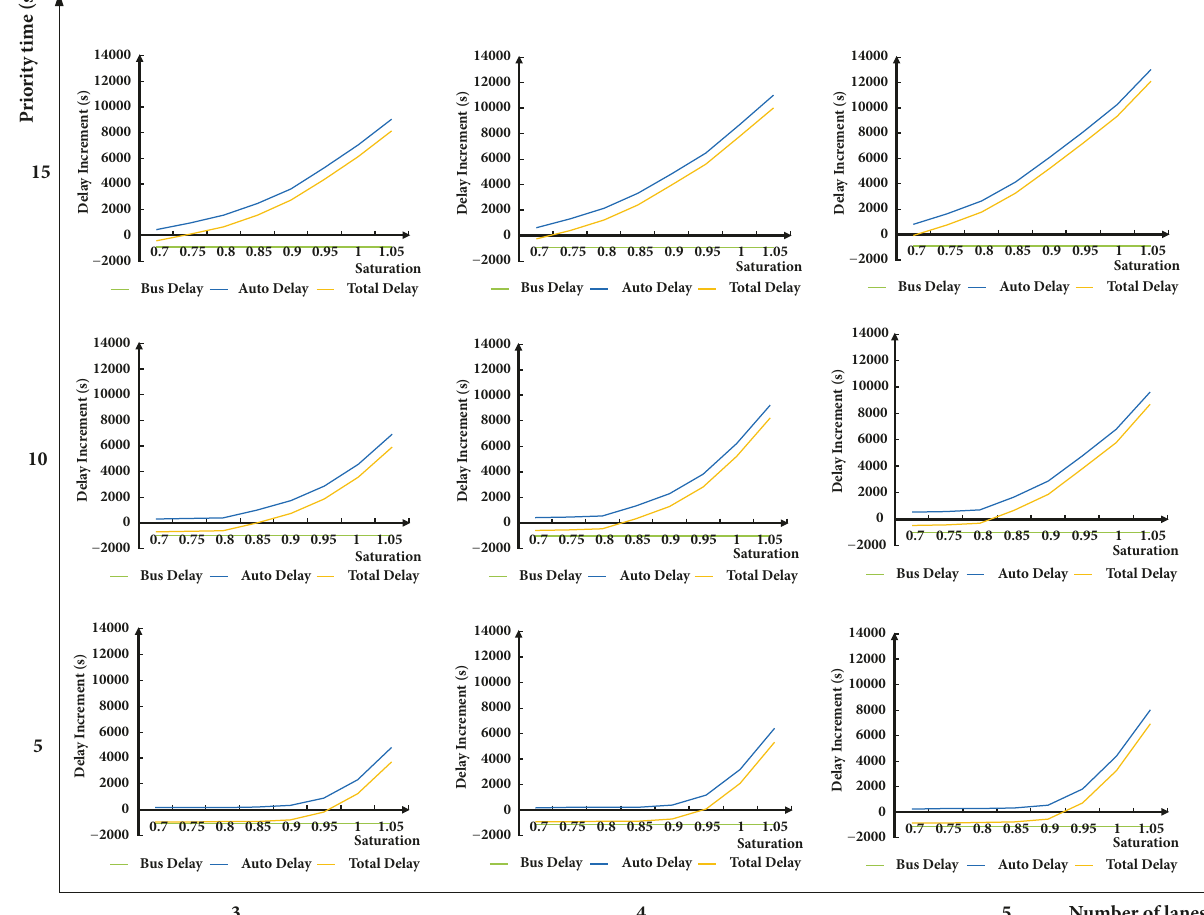
Figure 11: Sensitivity plots of the total delay increment to the priority time and the number of lanes.